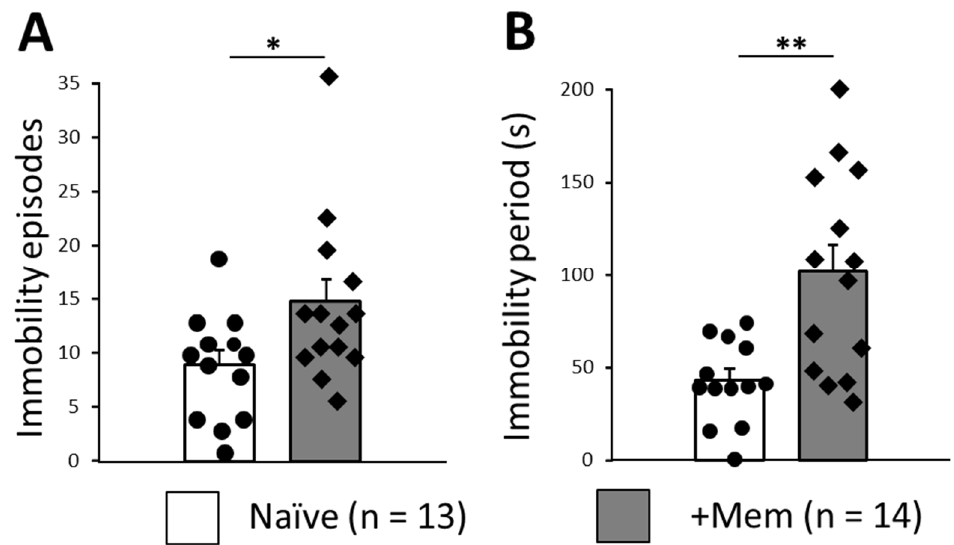
Figure 4. Tail suspension test demonstrates increased anxiety-like behavior in mice chronically treated with memantine. ( A ) Immobility episodes and ( B ) immobility period during 360 s total test duration. Individual data points are shown as closed circles for control mice and closed diamonds for memantine treated mice (* p < 0.05; ** p < 0.01).